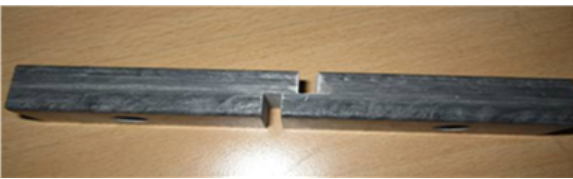
Figure 5: Experiment